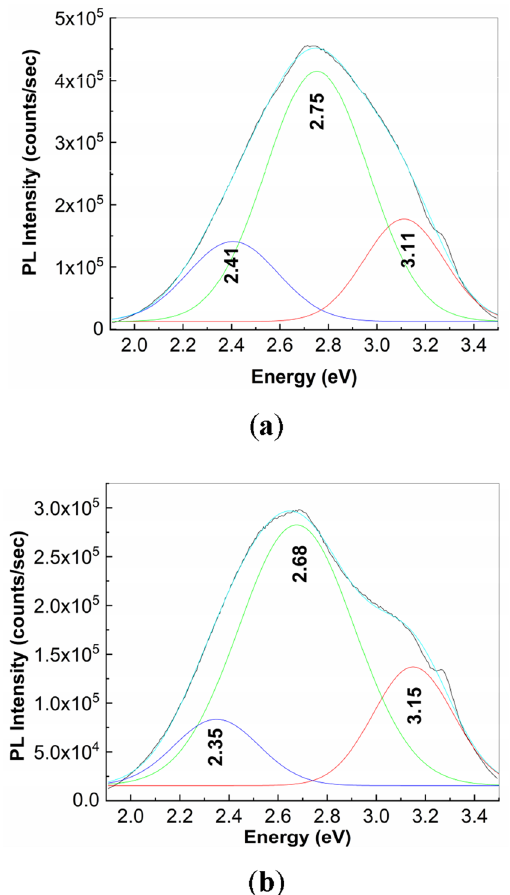
Figure 10. PL spectra of the sample resulted by the reaction of 1 ml PS ( 1 ) 2 mg/ml with 2 ml NaOH 0.3 M prior ( a ) and after the 300 min. exposure to UV light ( b